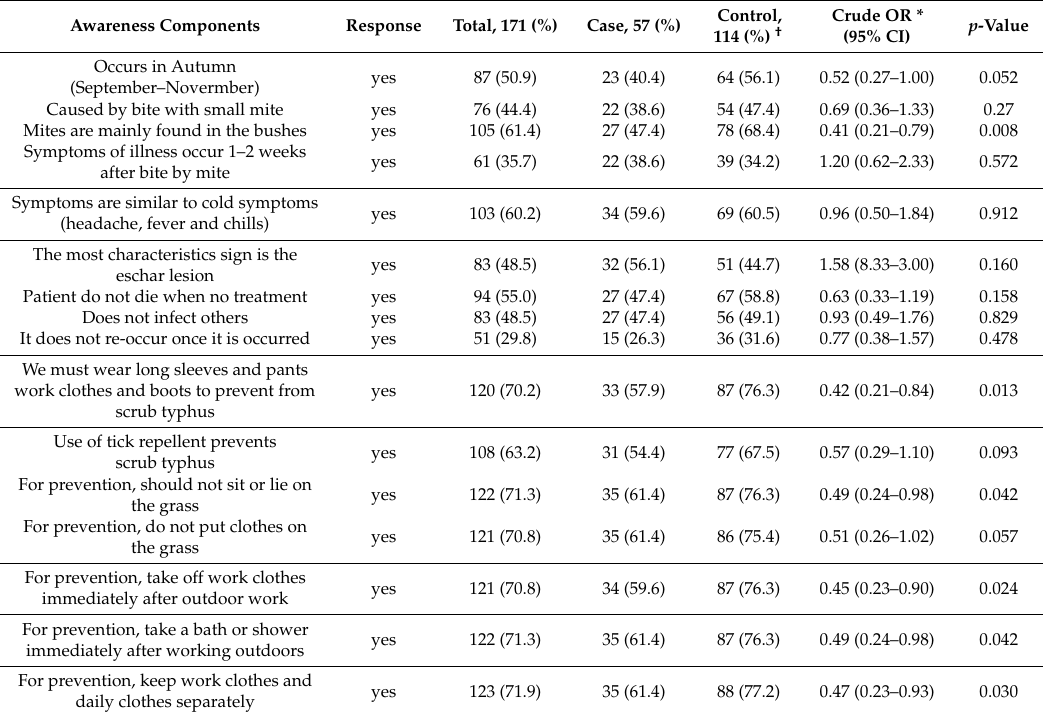
Table 2. Awareness of scrub typhus among cases and controls who were exposed within the previous one month in South Korea.